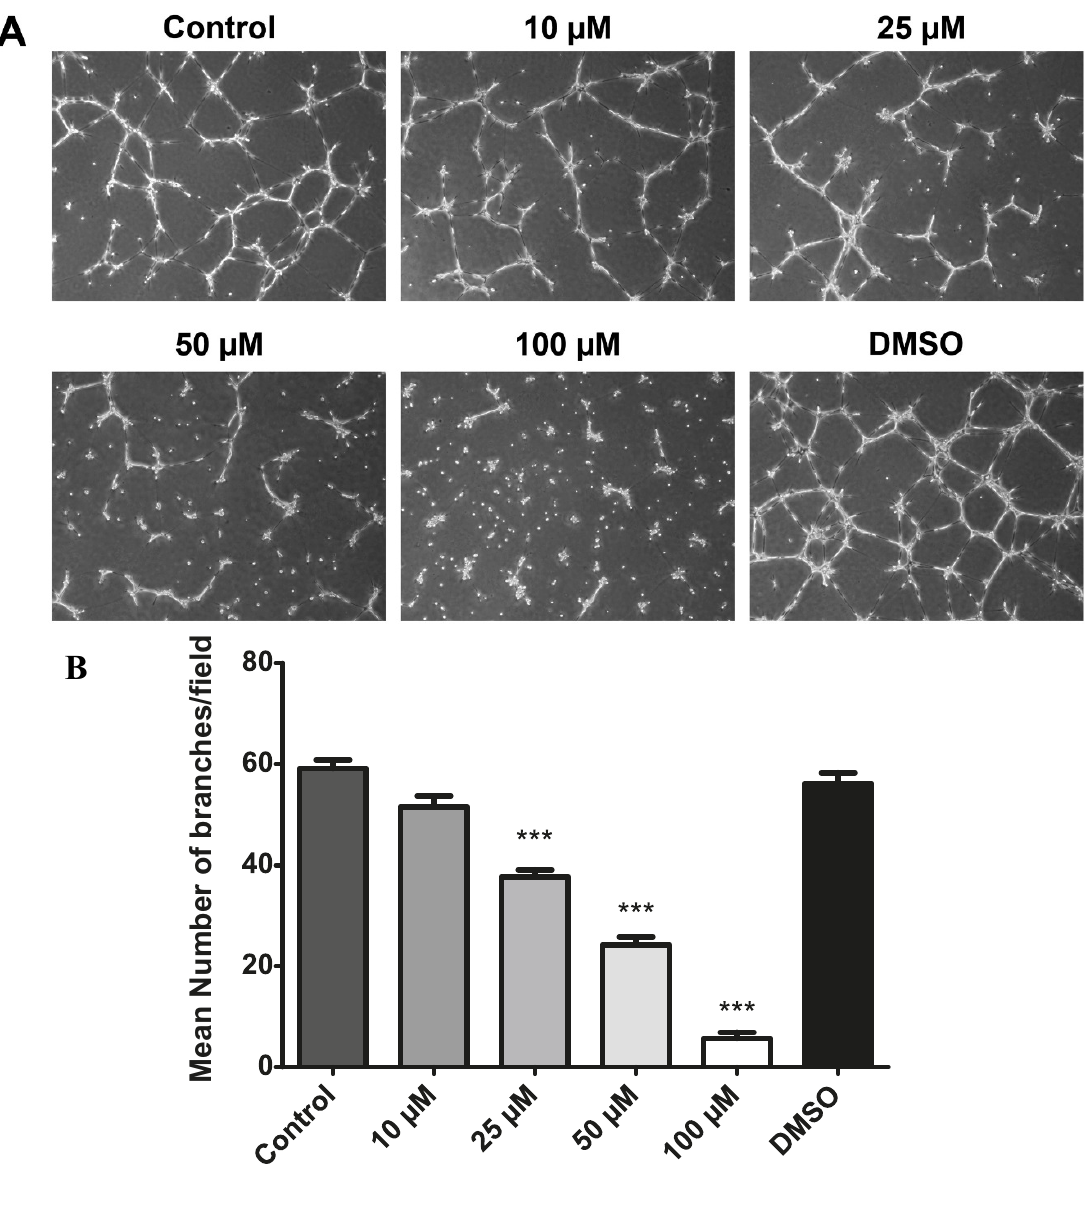
Figure 10. Resveratrol inhibits choroidal endothelial cell branching and network formation. Cells were plated on matrigel in the presence of different concentrations of resveratrol or vehicle controls. Cells were imaged fourteen hours post-treatment ( A ) and the number of branches counted ( B ). *** p ≤